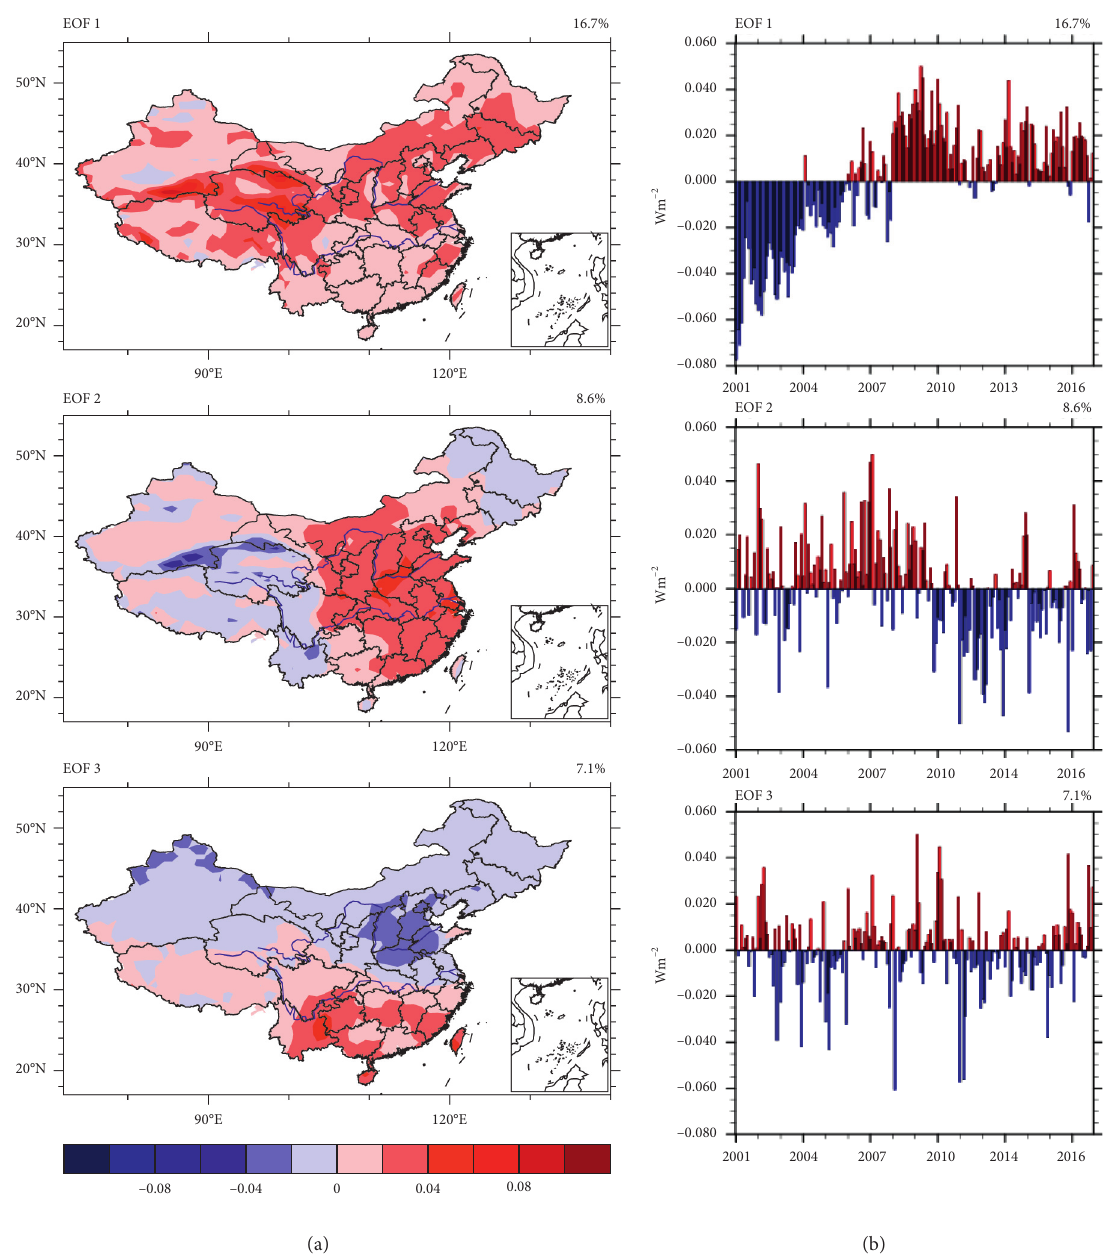
Figure 11: First three EOF modes of differences in LER in all-sky and clear-sky weather conditions (unit: Wm − 2 ) in China: (a) spatial distribution of EOF modes and (b) corresponding time